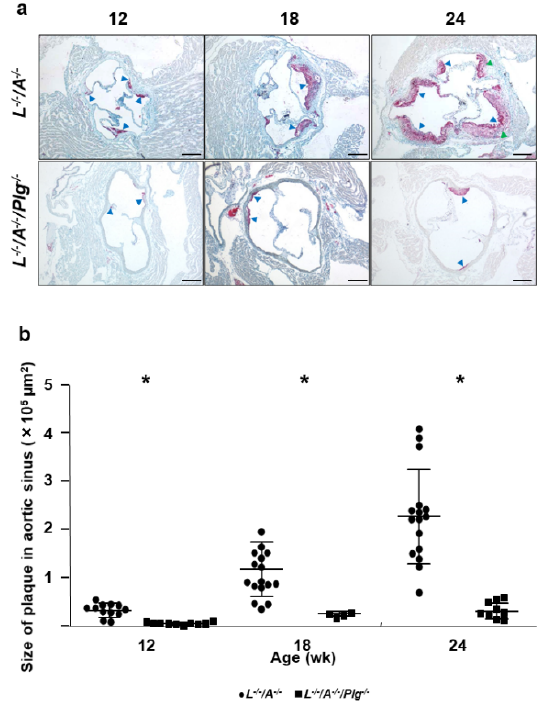
Figure 2. ( a ) Oil red O (ORO) stains for lipids associated with the aortic sinuses from L − / − /A − / − and L − / − /A − / − /Plg − / − male mice at various ages. In 12 wk L − / − /A − / − mice, there were dense droplets of lipids associated with the base of aortic valves (blue arrowheads). In 12 wk L − / − /A − / − /Plg − / − mice, the area of fat accumulation was smaller than in L − / − /A − / − (blue arrowheads). In 18 wk L − / − /A − / − mice, the neoin- tima was clearly observed with dense fat accumulation (blue arrowheads). In 18 wk L − / − /A − / − /Plg − / − mice, the area of fat accumulation was enhanced relative to 12 wk mice although neointima for- mation was significantly restricted compared with L − / − /A − / − at the same age (blue arrowheads). In 24 wk L − / − /A − / − mice, the neointima was enhanced (blue arrowheads). The lipid stains in the neointima became less dense particularly in the core due to the formation of complex plaque (green arrow- heads). In 24 wk L − / − /A − / − /Plg − / − mice, small and restricted neointima formation was observed (blue arrowheads). Original magnification, 40×. Bar = 250 µm. ( b ) Plaque sizes in aortic sinuses of L − / − /A − / − were 0.33 ± 0.15, 1.2 ± 0.57, and 2.3 ± 0.93 at 12, 18, and 24 wk of age, respectively (circles). Those in L − / − /A − / − /Plg − / − mice was 0.046 ± 0.026, 0.23 ± 0.045, and 0.31 ± 0.17 at 12, 18, and 24 wk of age, respec- tively. Those in L − / − /A − / − /Plg − / − (squares) mice, as revealed by morphometric analysis of ORO-stained slides ( n = 4–16). * p < 0.05.